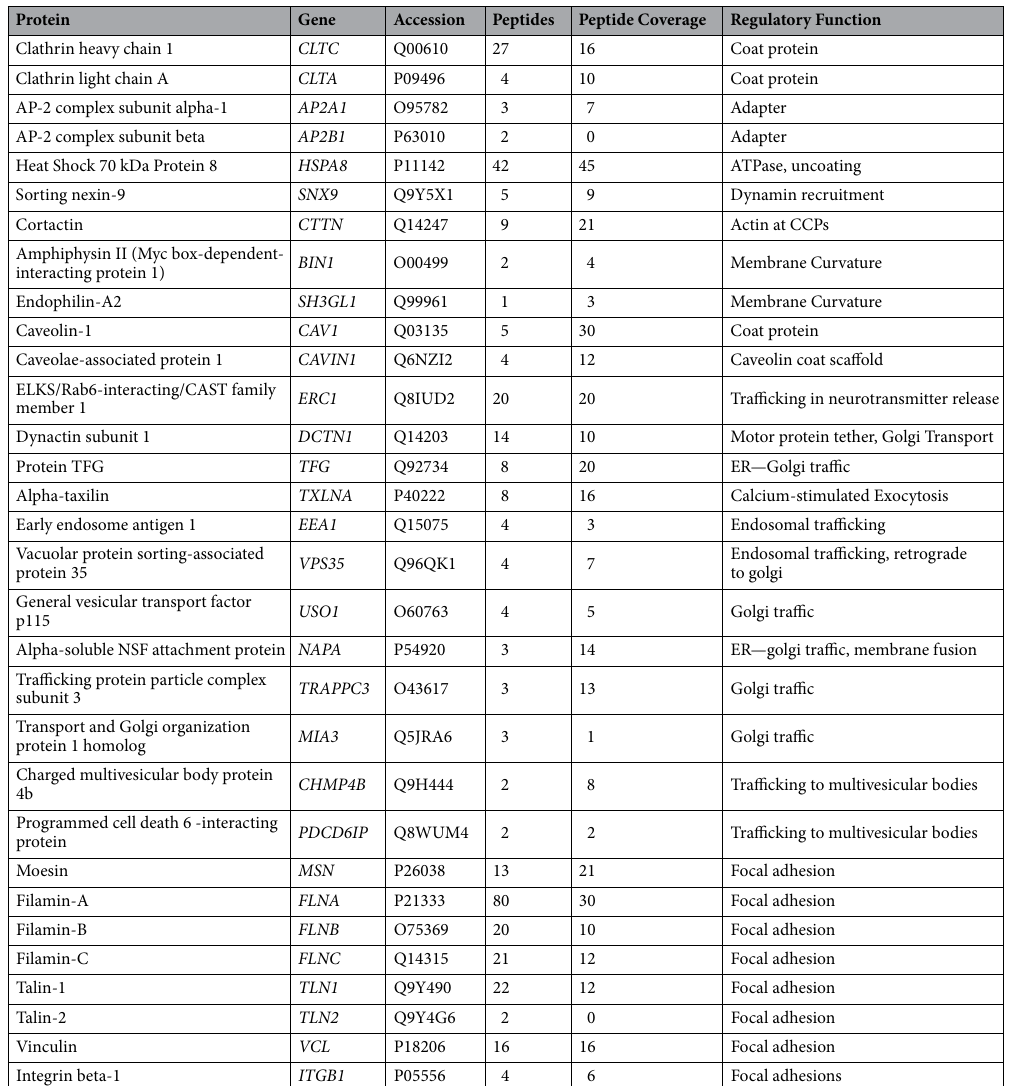
Table 1. Unbiased proteomic screen of PEA-15 co-immunoprecipitation. PEA-15 was immunoprecipitated from lysates of U87MG. Co-immunoprecipitants were detected by mass spectroscopy and proteomic analysis. Shown is a subset of identified proteins that includes known regulators of endosomal traffic. Proteins are categorized by function and then by number of detected peptides. All proteins listed here were also detected in a parallel experiment with cells overexpressing HA-tagged-PEA-15 and immunoprecipitation with anti-HA